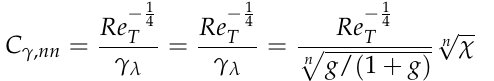
Figure 8. Model sensitivity to 𝐶 (cid:3099) as a function of 1/(cid:3435)𝐷𝑎